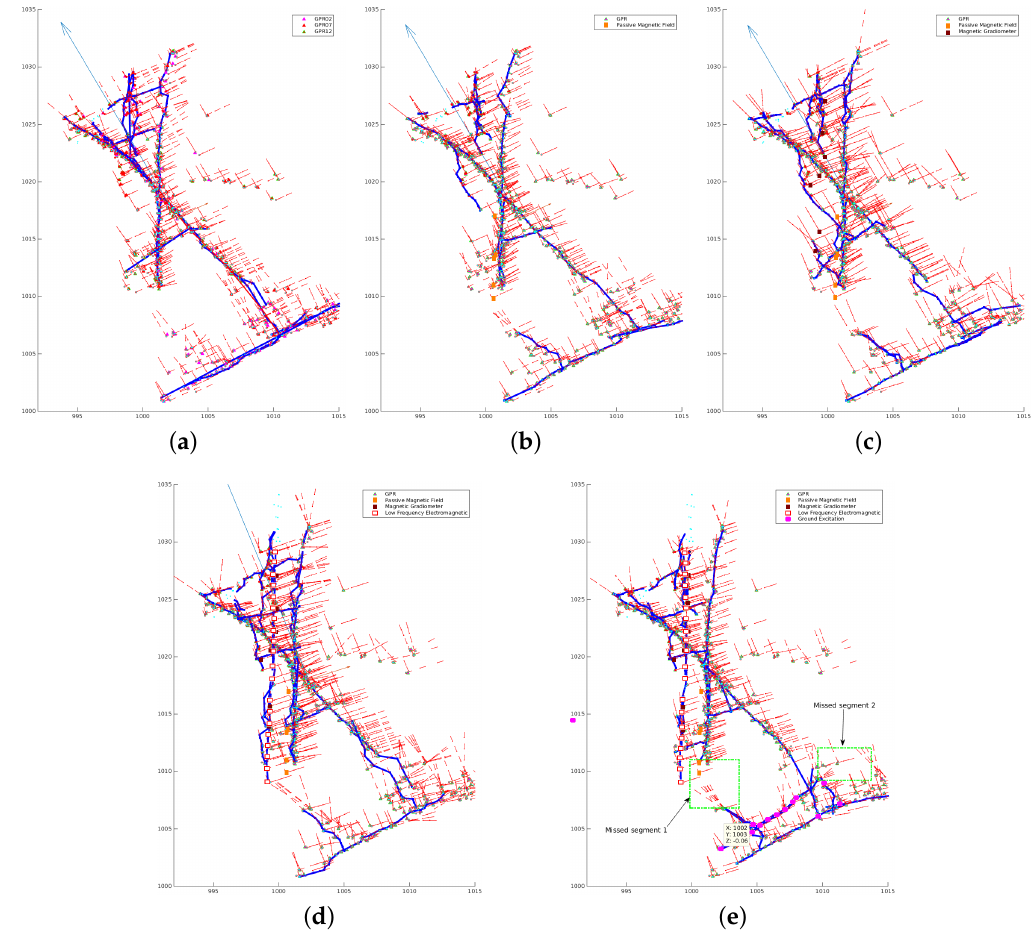
Figure 13. Experimental results of the MCS algorithm with virtual scan lines on real data captured in the Glen Eyre survey. ( a ) GPR; ( b ) GPR + PMF; ( c ) GPR + PMF + MG; ( d ) GPR + PMF + MG + LFEM; ( e ) GPR + PMF + MG + LFEM + VA. Hypothesized detections from different sensors are marked by different symbols, as shown in the legend; projections of the hypothesized detections on the corresponding virtual scan lines are marked by cyan dots; the predicted utility states at different locations are marked by red line arrows; and the located buried utilities are marked by bold blue